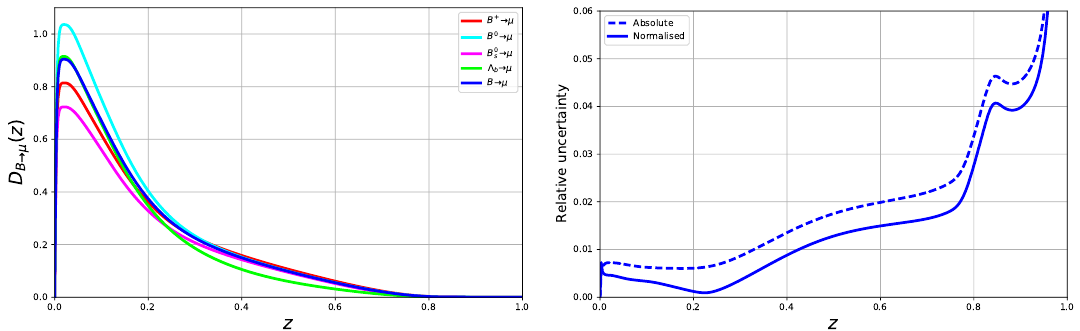
Figure 7 . Left: the muon decay fragmentation function for the high-energy B-hadron mixture. Right: the corresponding uncertainty plot. The error bands are obtained as described in section